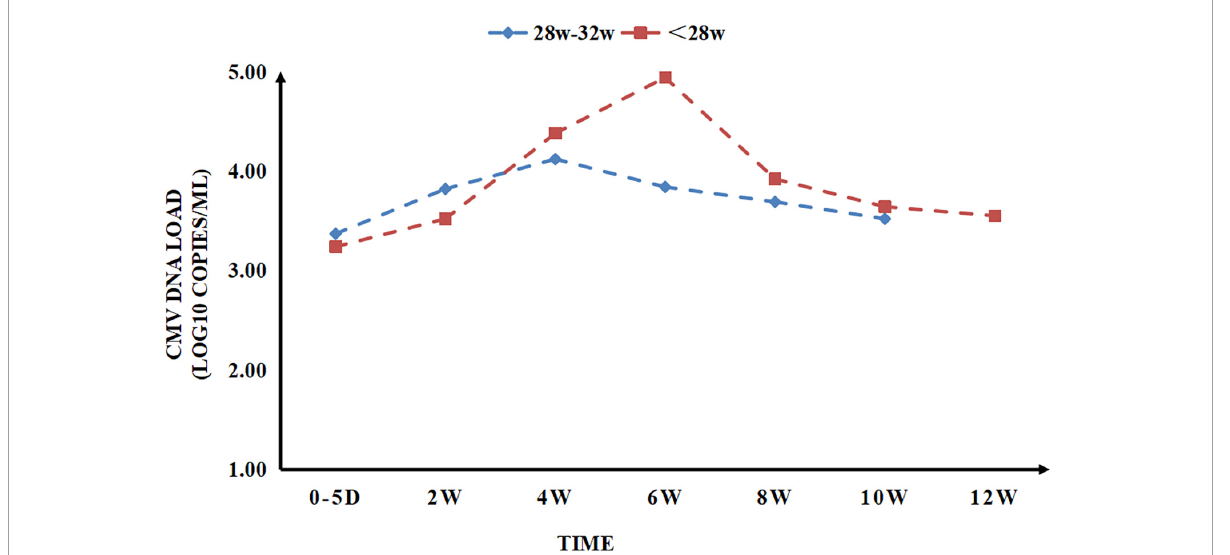
FIGURE2 Cytomegalovirus (CMV) detoxification rule of very/extremely premature infants (VPI/EPI).